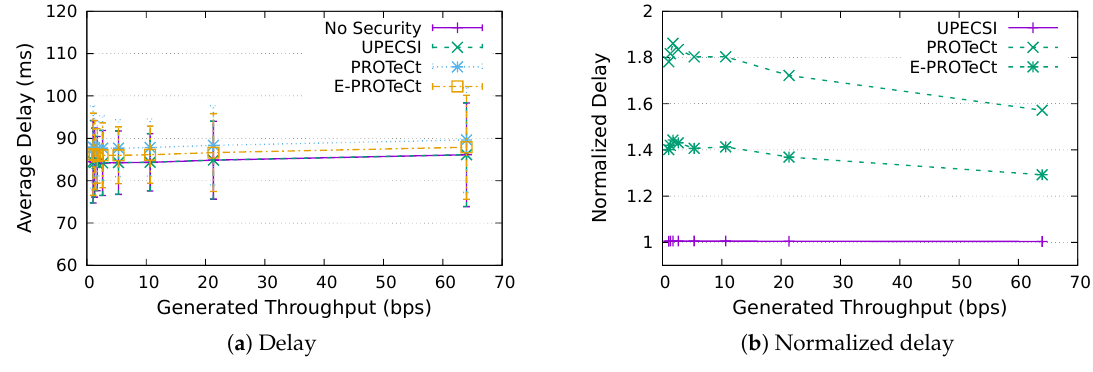
Figure 11. Delay analysis for an IoT network with four